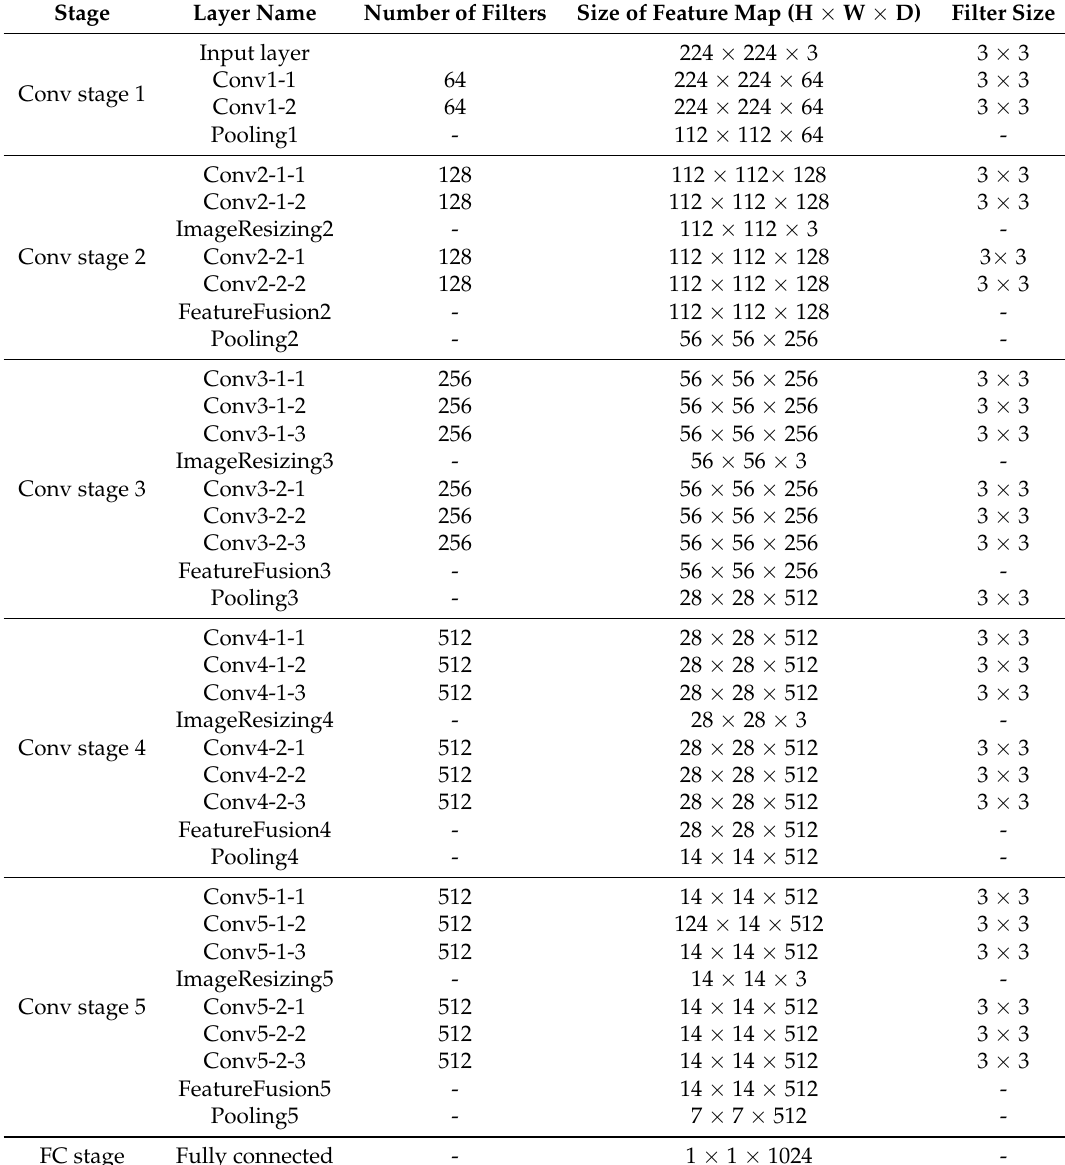
Table 2. A detailed summary of the PSI-CNN